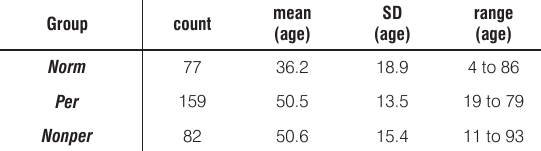
Table 1. Basic clinical characteristics of the patient